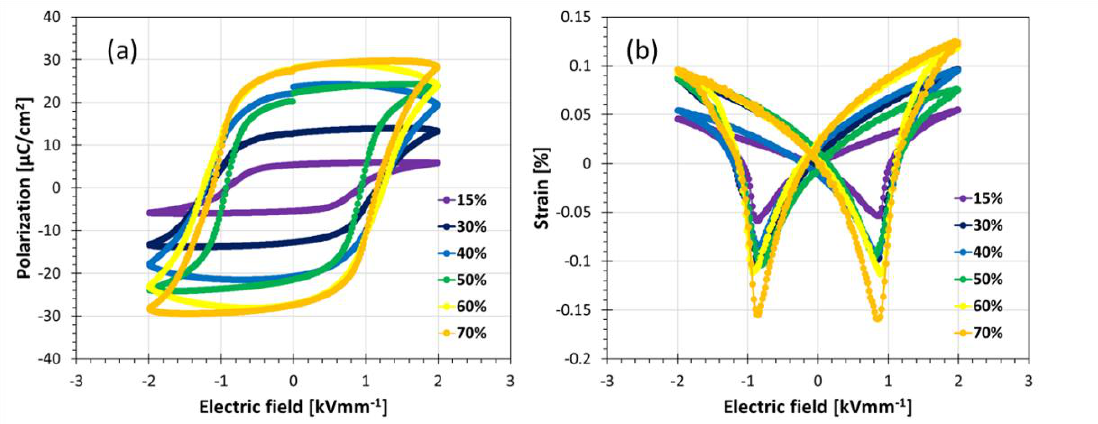
Figure 7. Piezoelectric properties ( a ) polarization hysteresis and ( b ) strain hysteresis of PZT composites with 3-3 connectivity.